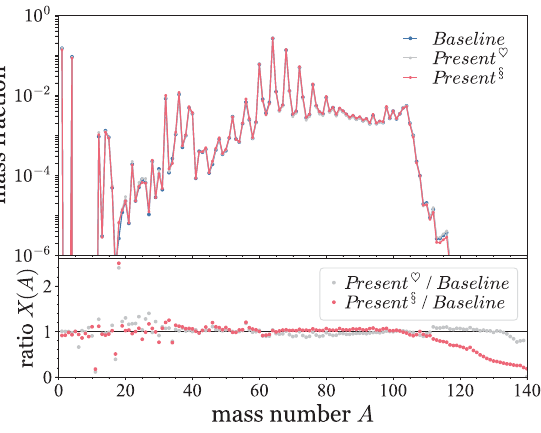
Figure 2. The averaged mass fractions for each mass number at burst tail end when t ≈ 180 s after the burst peak. The GS 1826 − 24 model from Jacobs et al . [10] is the adjusted to reproduce the recurrence time of Epoch Jun 1998 . The model uses JINA REACLIB v2.2. and is named as baseline model. The Present § (or Present ♥ ) model adopts the same astrophysical configurations of baseline but implement the Present (or Langer et al .) 57 Cu(p, γ ) 58 Zn, Kahl et al . [7] 56 Ni(p, γ ) 57 Cu and Valverde et al . [8] 55 Ni(p, γ ) 56 Cu rates, see